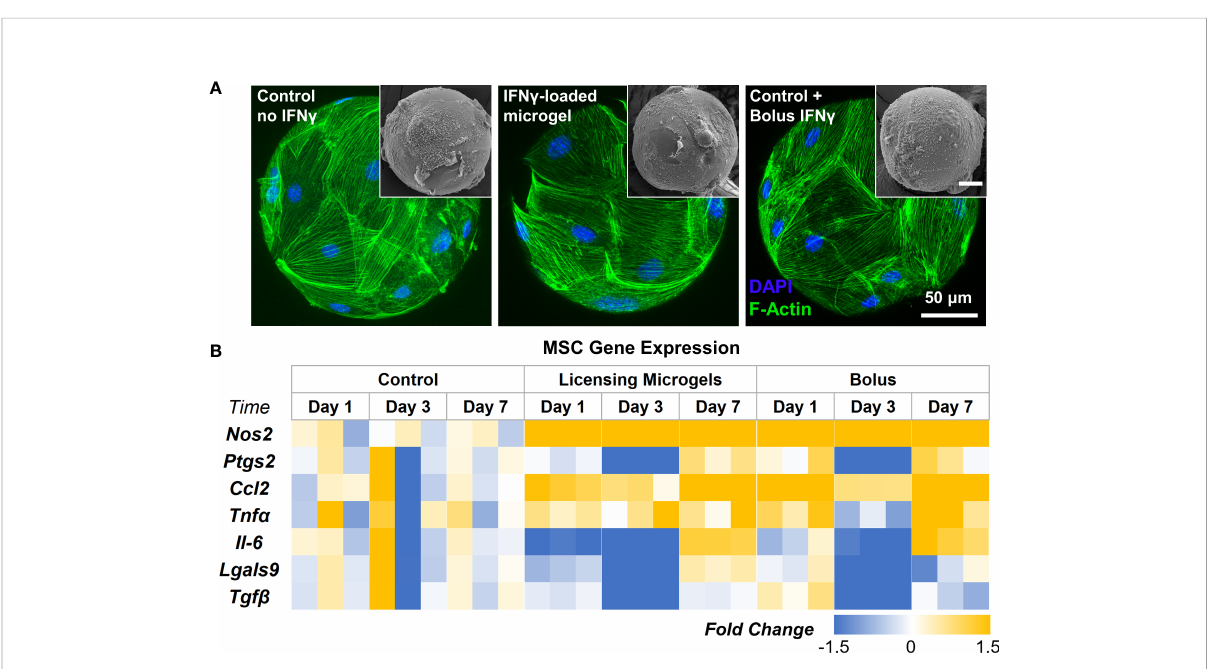
FIGURE 6 Gene Expression of AD-MSC Seeded on licensing Microgels. (A) Confocal Z-stacks of microgels seeded with AD-MSC (Control microgels, IFN g loaded microgels, and IFN g bolus treatment). (Insets) Corresponding SEM images of microgels. (B) Heatmap showing gene expression of in fl ammatory and anti-in fl ammatory AD-MSC phenotypes. Heatmaps show fold change with respect to the housekeeping gene (Gapdh) and no treatment control group.